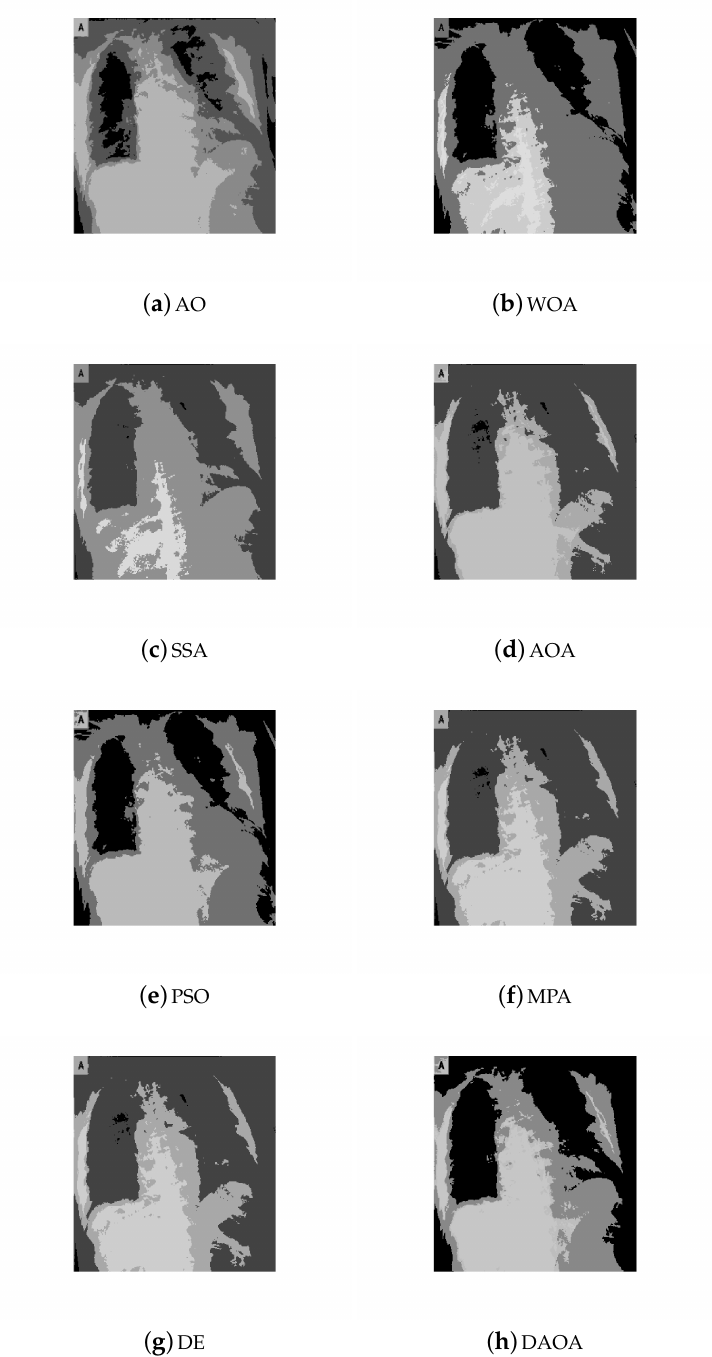
Figure 7. The segmented image (Test 8) by the comparative methods when the threshold value is